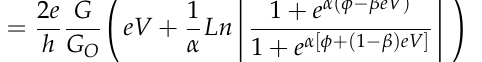
2 O 3 layers deposited using TALD process at 300